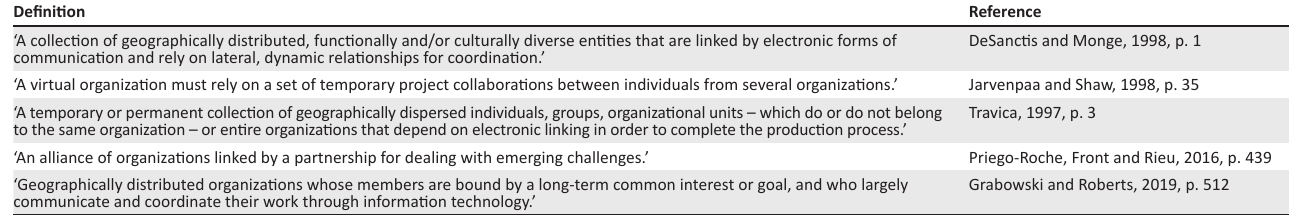
TABLE 6: A selection of virtual organisation